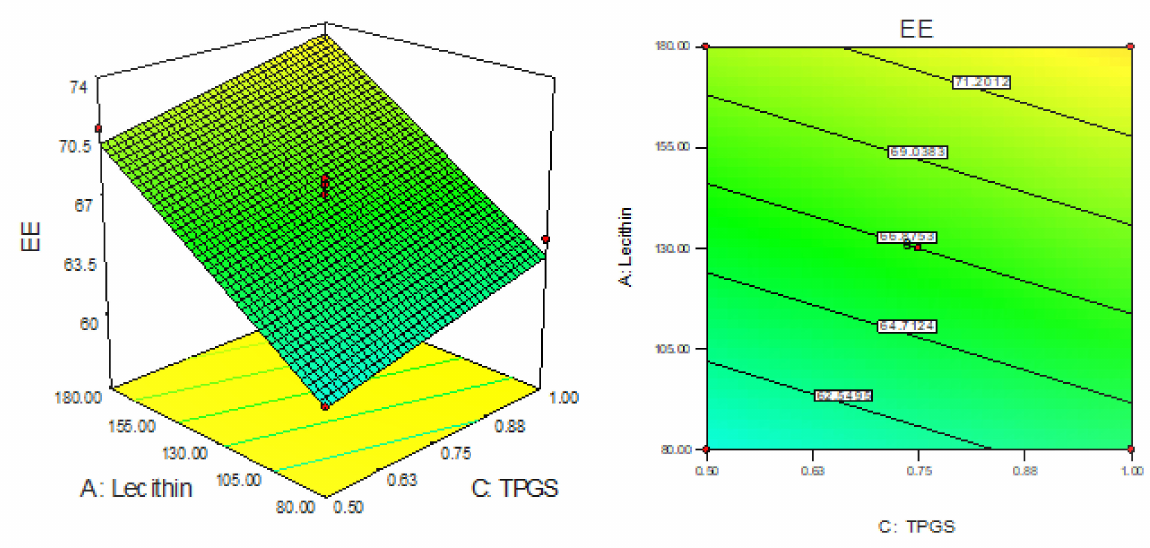
Figure 3. 3D response surface plot showing the effect on independent variables on encapsulation efficiency (Y 2 ).